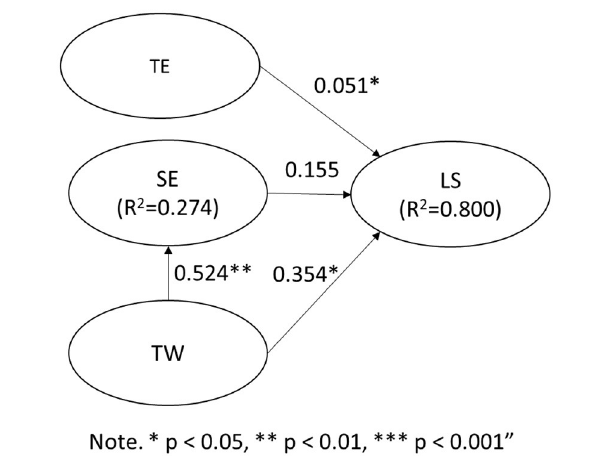
FIGURE 3 | PLS statistical model diagram. LS, Learning Satisfaction; SE, Self efficacy; TE, Teaching; TW, Team